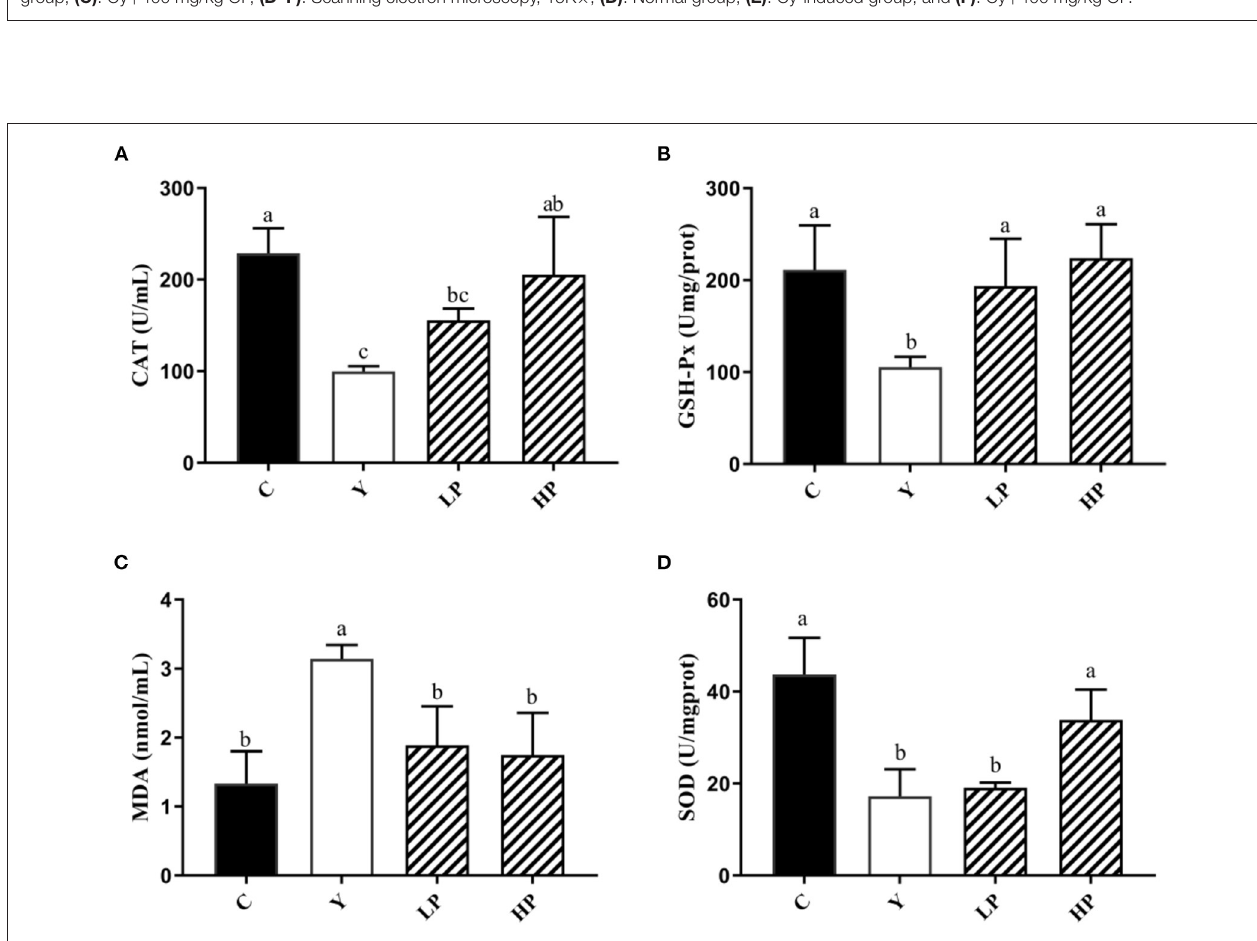
FIGURE 4 | Effects of OP on the contents of CAT (A) , GSH-Px (B) , MDA (C) , and SOD (D) in serum of oxidative injured mice. Different letters in the figure represent significant differences ( P < 0.05). C: the normal group; Y: the Cy-induced group; LP: Cy + 200 mg/kg OP; HP: Cy + 400 mg/kg OP.